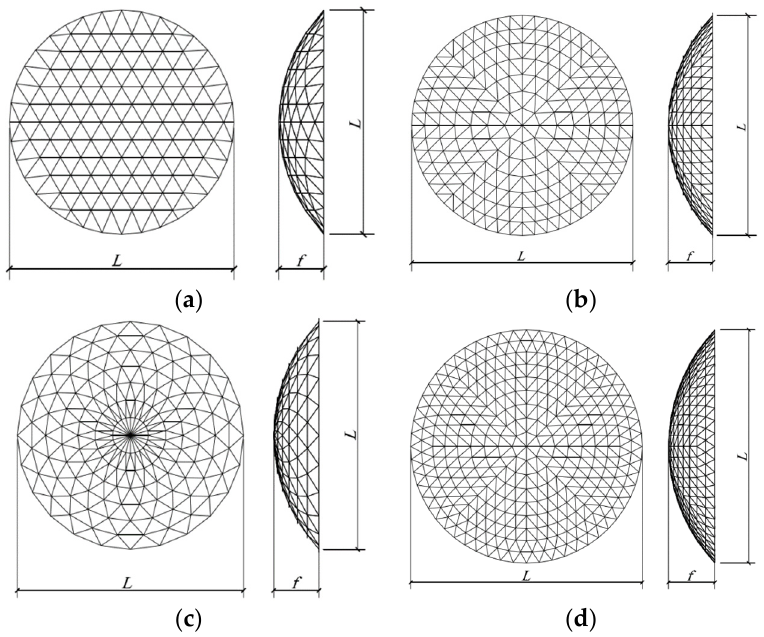
Figure 3. The single-layer reticulated shell models. ( a ) Geodesic; ( b ) Kiewitt; ( c ) Sunflower; ( d ) Kiewitt 8-Sunflower. Table 1. Parameters of single-layer reticulated shells.